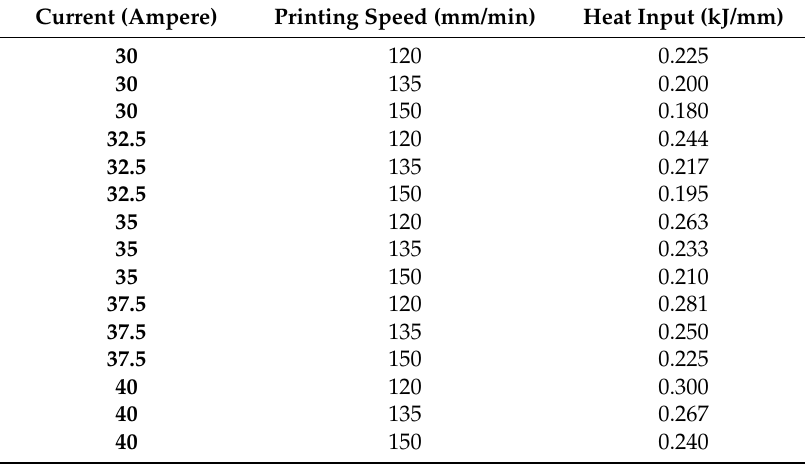
Table 3. Combination of parameters during